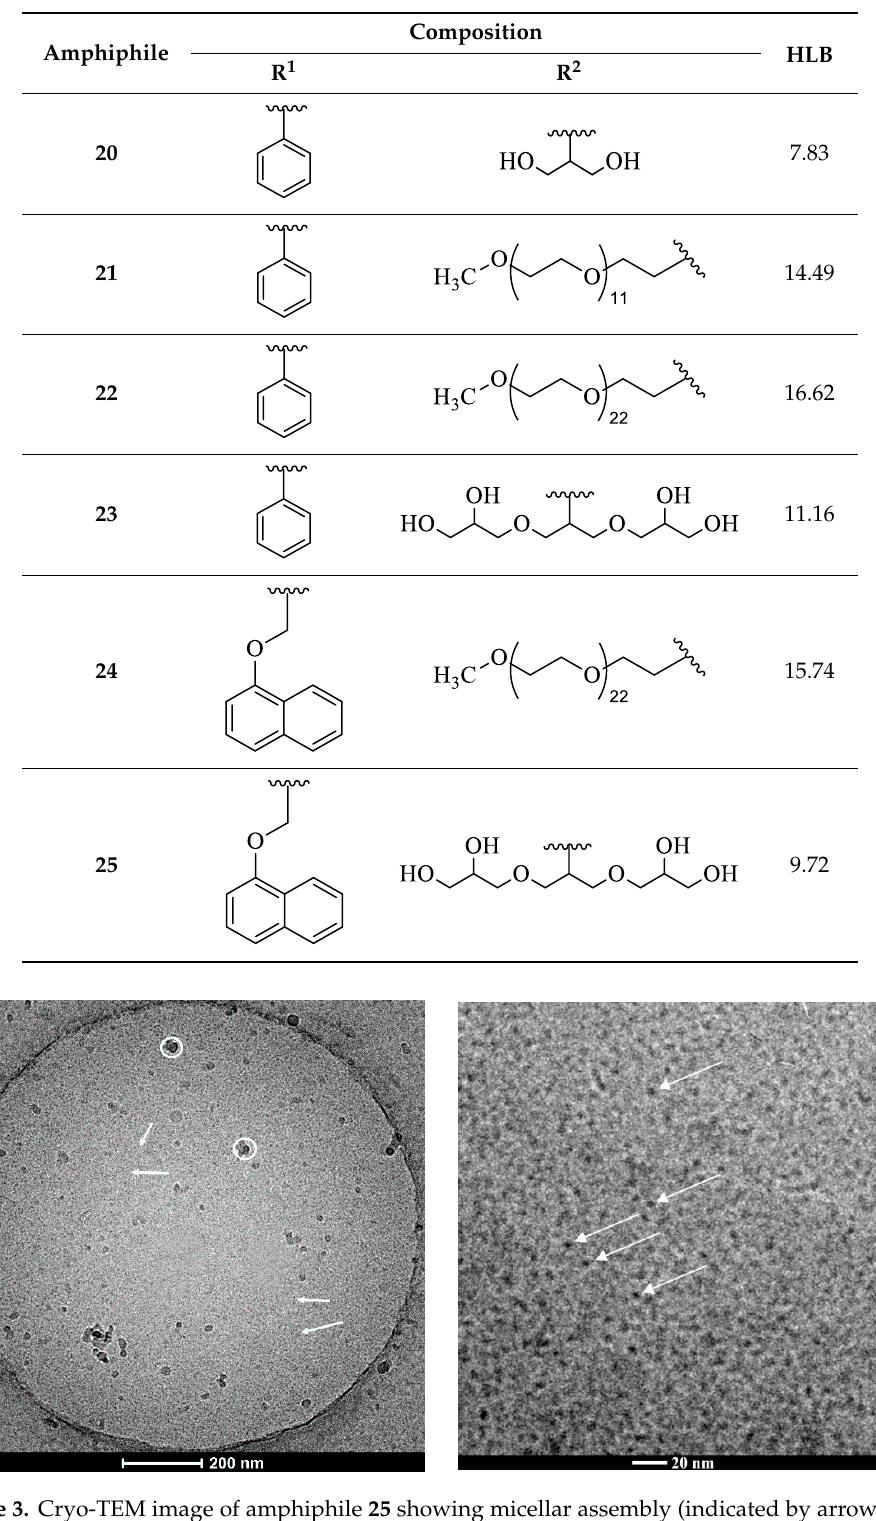
Table 2. Hydrophilic–lipophilic balance (HLB) value of amphiphiles ( 20–25 ) determined using Gri ffi n equation [35].